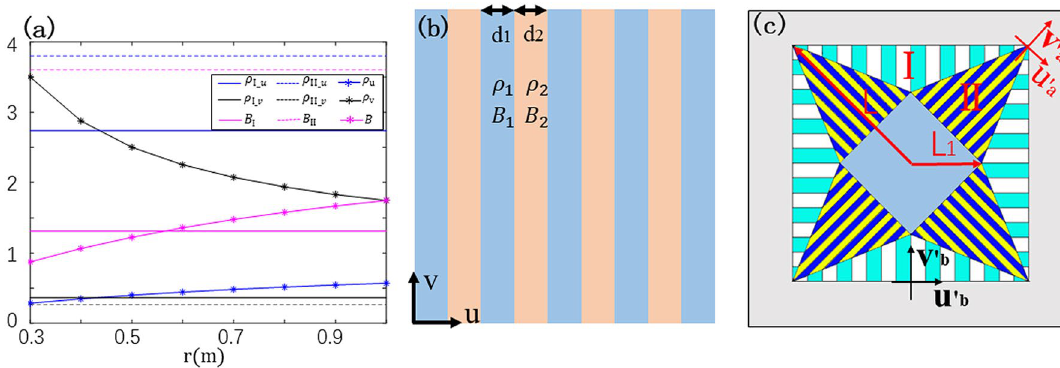
Figure 2. ( a ) Distribution of density and bulk modulus between our own design and Ref. 23. Normalized density components in u and v directions and bulk modulus are drawn in blue, black and carmine lines respectively. The dash dot lines represent the parameters of Ref. 23 while straight lines and dotted lines are normalized densities and bulk modulus of region I and region II of our design. The horizontal ordinate represents the distance to the center of the device, and vertical ordinate is the normalized ratio; ( b ) geometric sketch of layered structure. Two structures with different density and bulk modulus are arranged alternately; ( c ) the layered structure schematic of the acoustic concentrator. L 1 and L are the boundary dimension of the inner and outer quadrilateral: L 1 = 0.3 m, L = 1.0 m